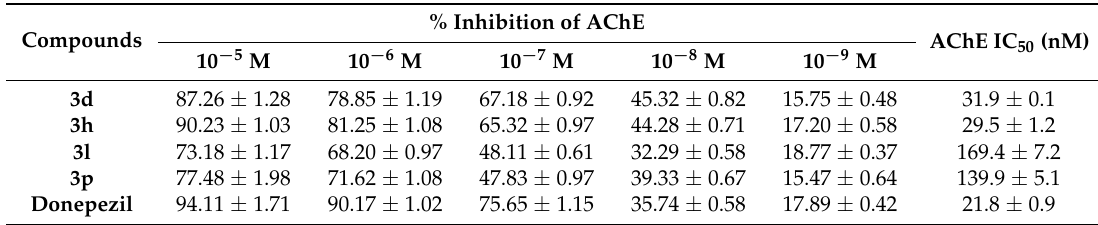
Table 2. IC 50 values of selected compounds ( 3d , 3h , 3l and 3p ) and donepezil, as a reference drug, on AChE